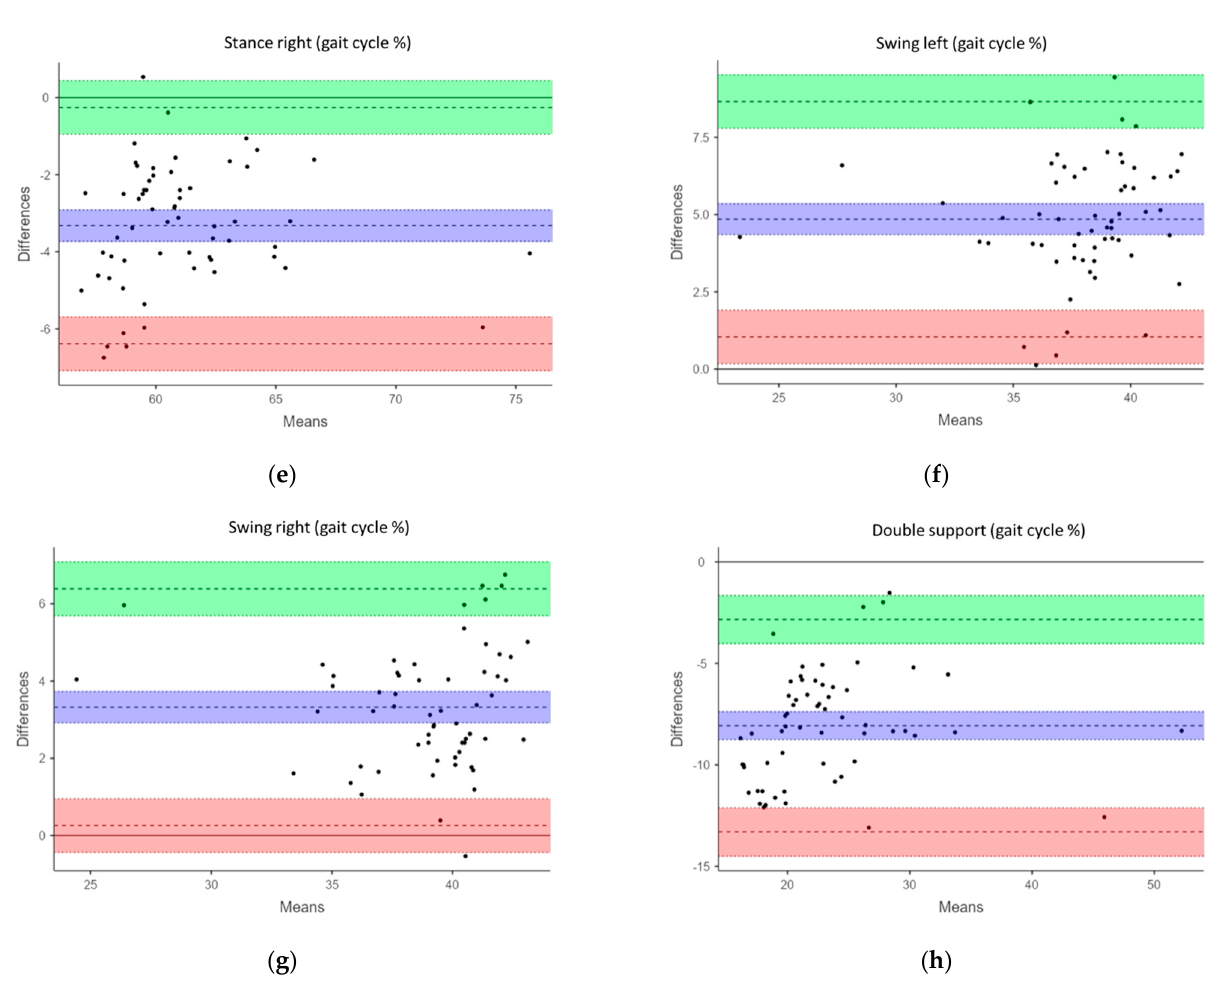
Figure 2. ( a – h ): Bland-Altman plots (taken directly from the Jamovi platform) for ( a ) gait speed, ( b ) cadence, ( c ) step length, ( d ) stance left gait cycle %, ( e ) stance right gait cycle %, ( f ) swing left gait cycle %, ( g ) swing right gait cycle %, and ( h ) double support gait cycle %. Dashed lines indicate upper and lower 95% limits of agreement (±1.96 SD of the bias).